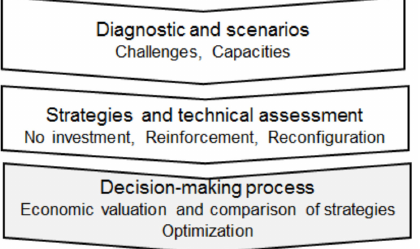
Figure 1. Stages of investment studies. Source: own elaboration adapted from